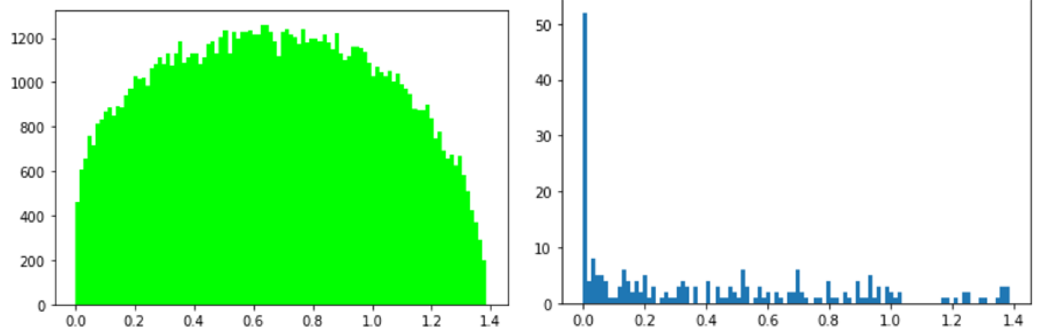
Figure 8 . Left : histogram plot on 100,000 random samples for the entropy of J in su (4) . The num- ber of bins used is 100. We note the range of [1 . 75 e- 5 , 1 . 39] . The 0 . 1 , 0 . 5 , 1 , 5 , 10 , 25 , 50 percentiles are 0 . 0036 , 0 . 0148 , 0 . 0262 , 0 . 0995 , 0 . 1779 , 0 . 3725 , 0 . 6645 , respectively. The mean and variance are 0 . 668 , 0 . 1279 . Right : histogram plot with 100 bins on the entropy of J in the 252 solutions for su (4) . We observe a strong signal of low entropy compared to the random baseline where 56 and 79 entries are below the 1 and 5 percentile,